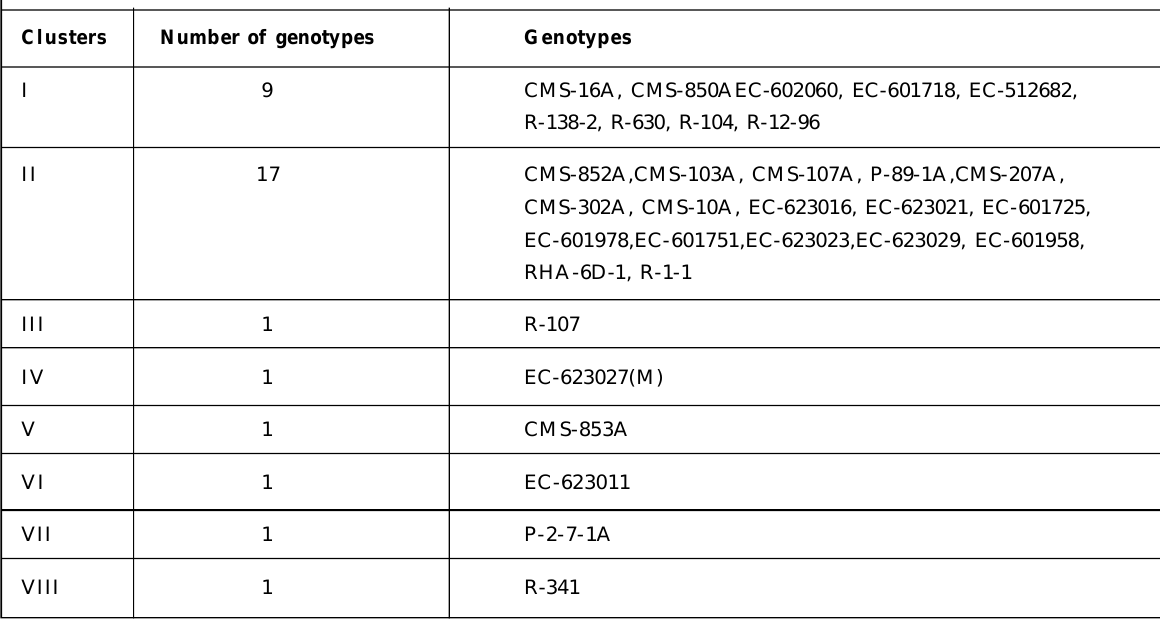
Table 6: Clustering of 32 sunflower genotypes according to quantitative traits Clusters Number of